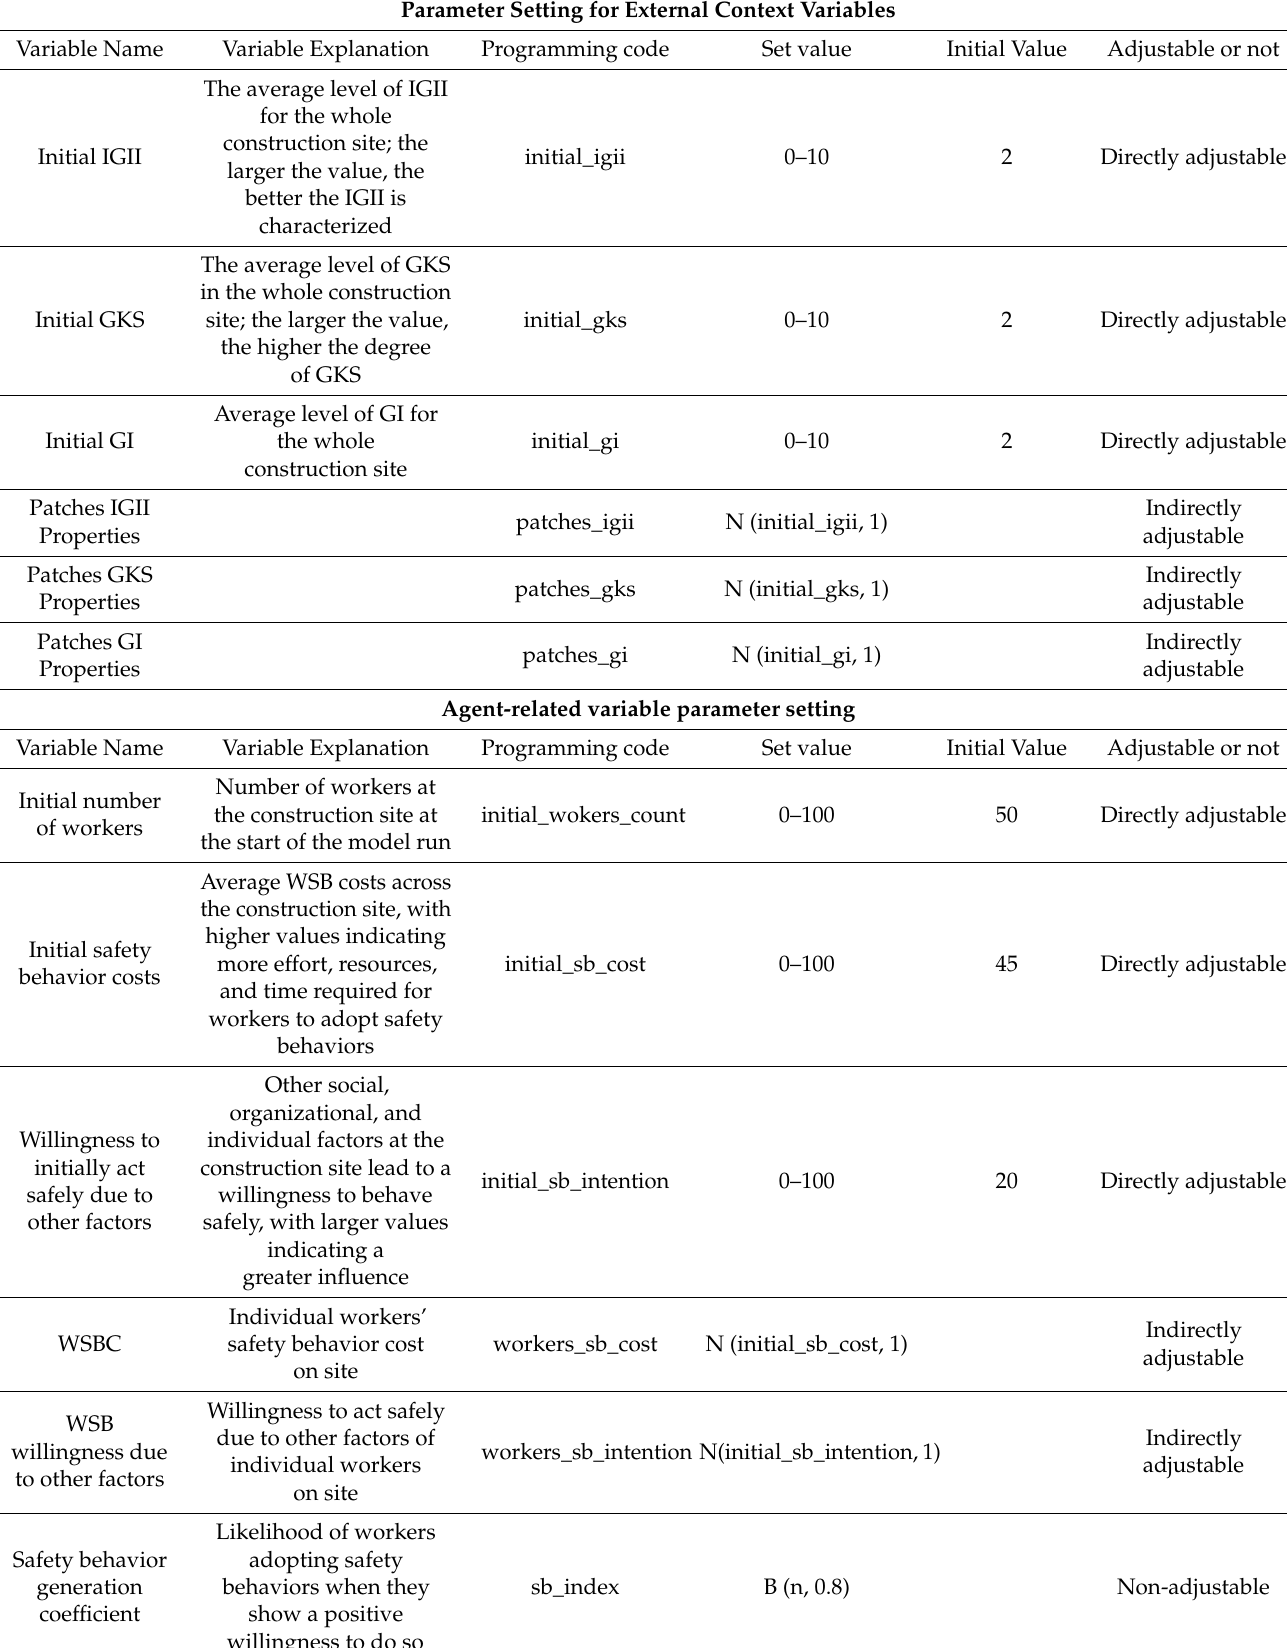
Table 1. Variable parameter